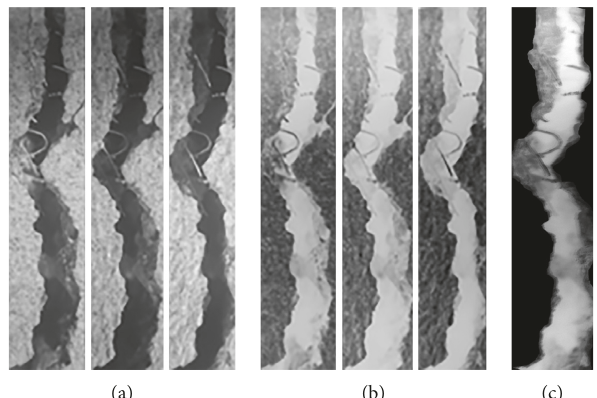
Figure 11: Crack images obtained with 3 different illumination angles: (a) three images at different angles of illuminations, (b) gray level inverted image of (a), and (c) the combined image of the three images in (a).